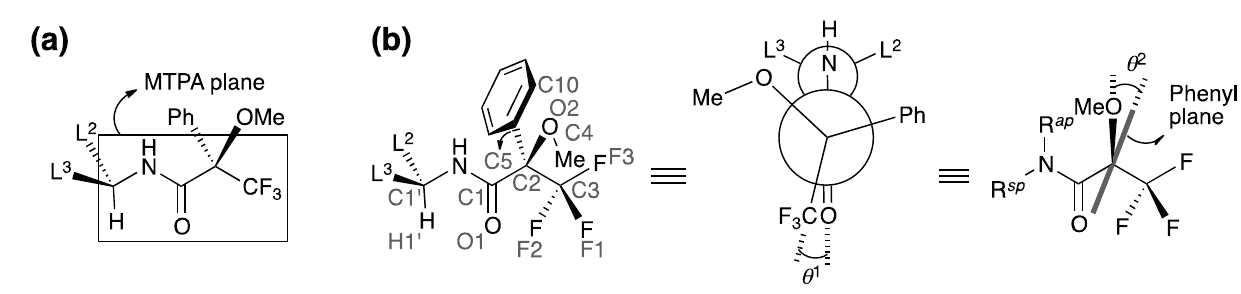
Figure 1. Structures of chiral resolving